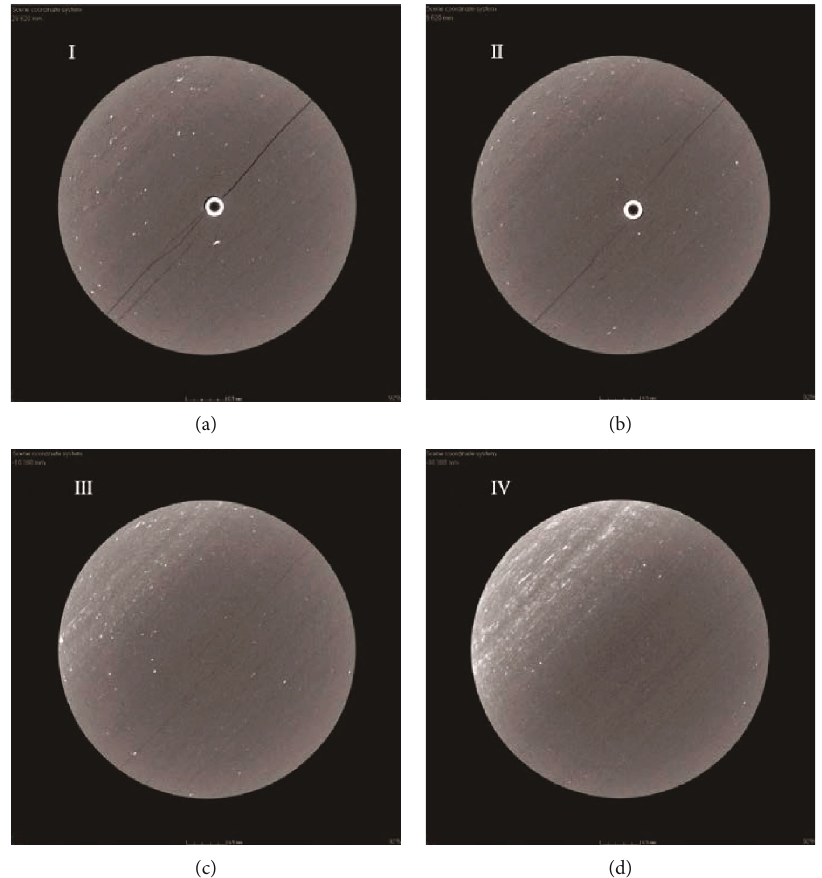
Figure 8: Four horizontal slices of the micro-CT scanning results of rock sample H2. (a – d) Correspond to the horizontal slices at heights of 20mm, 40mm, 60 mm, and 80mm, respectively.